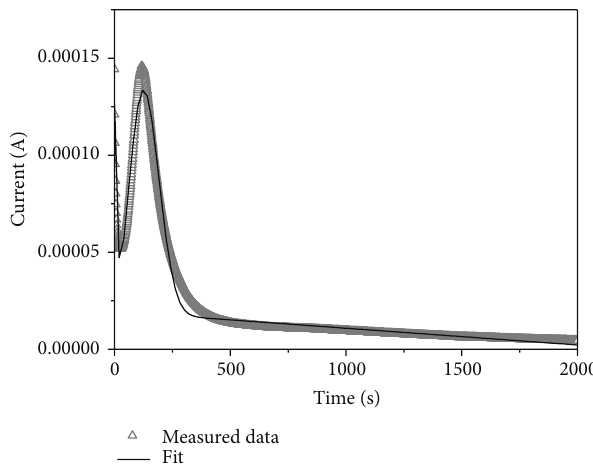
Figure 7: Photocurrent transient after turning on the light at 𝑡 = 0 (grey triangles) and a fit of the data with (8) (black